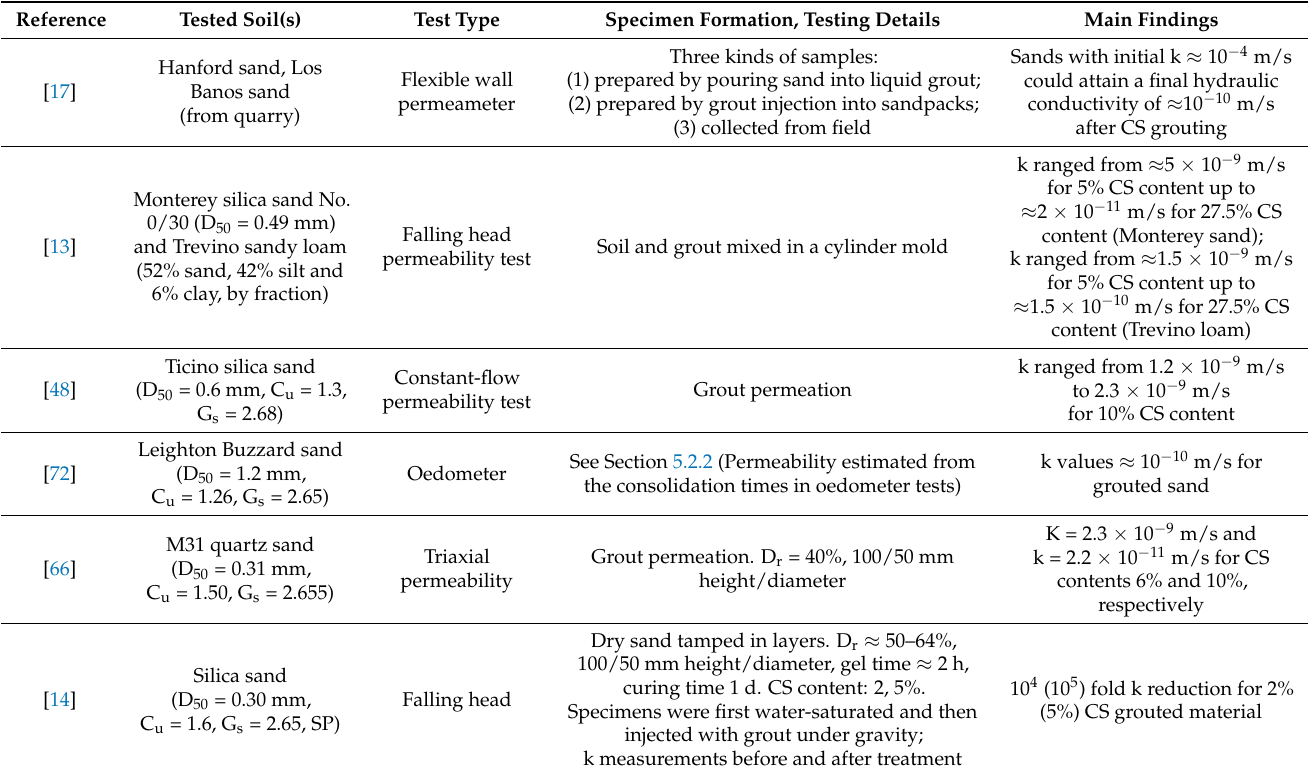
Table 1. Significant studies on the effects of CS grouting on the soil hydraulic